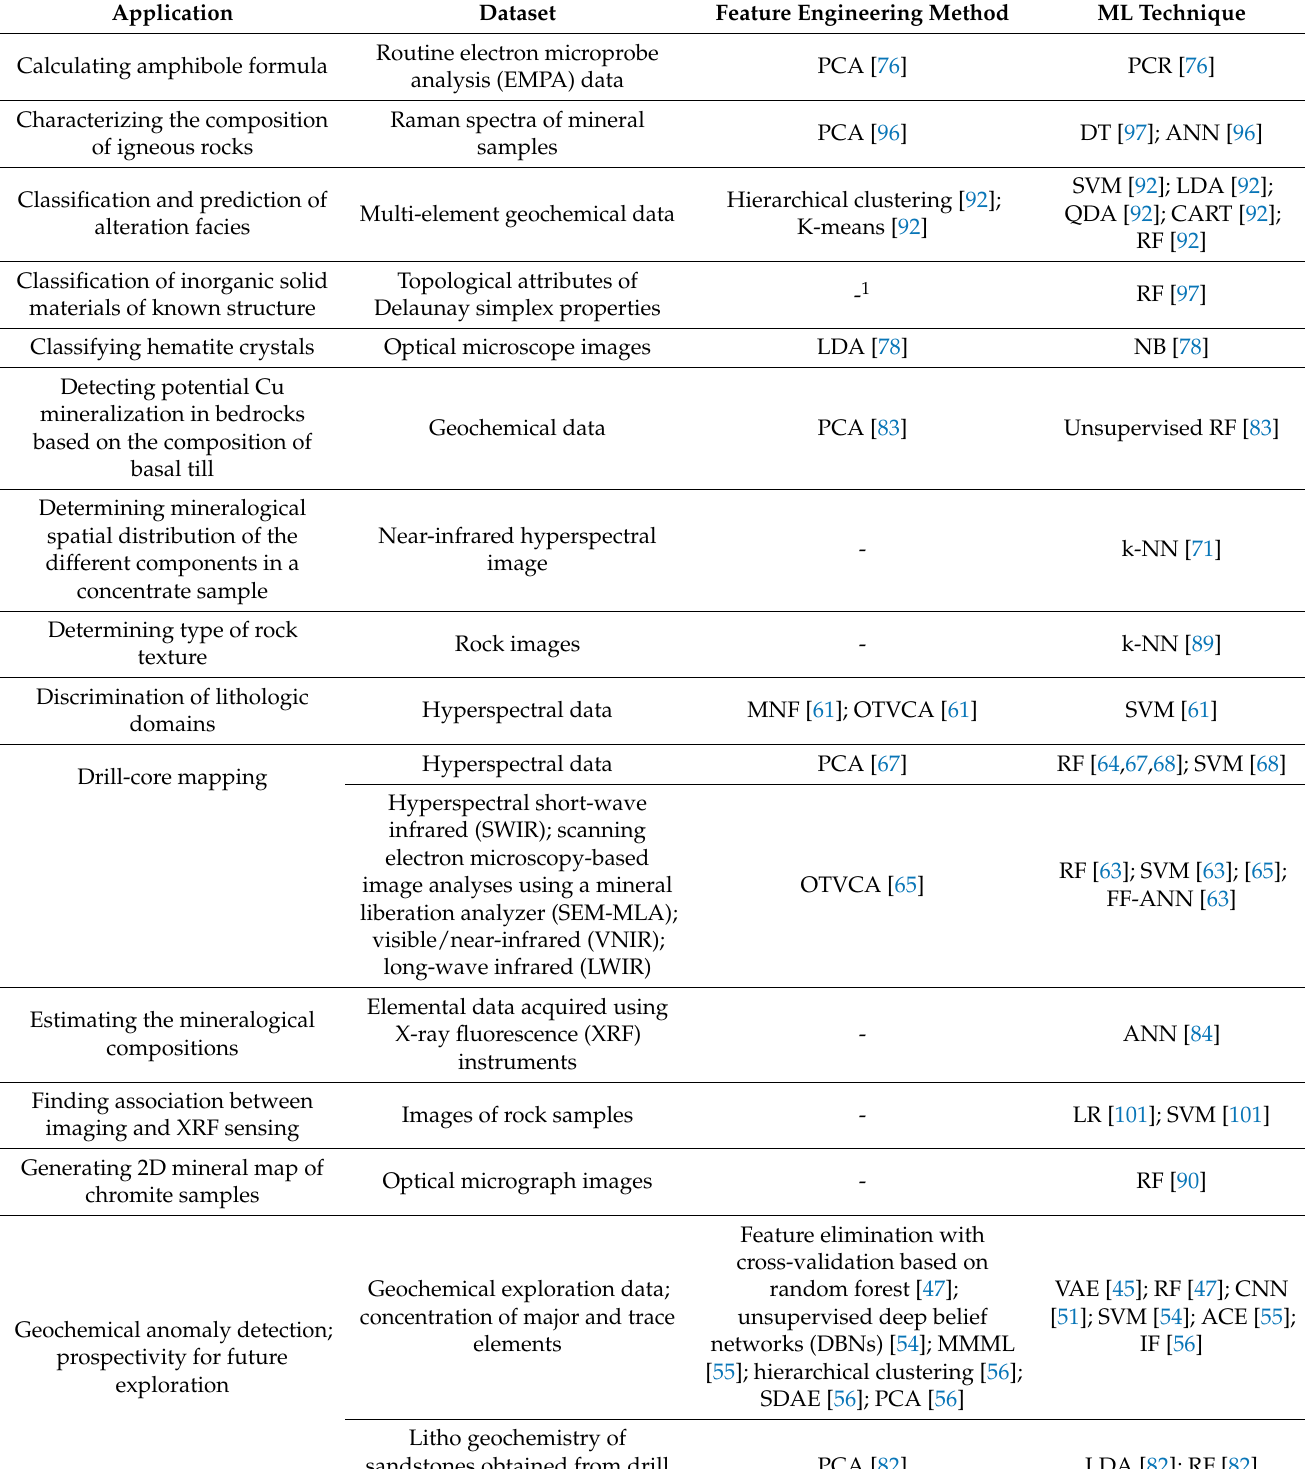
Table 3. ML models leveraged—application and